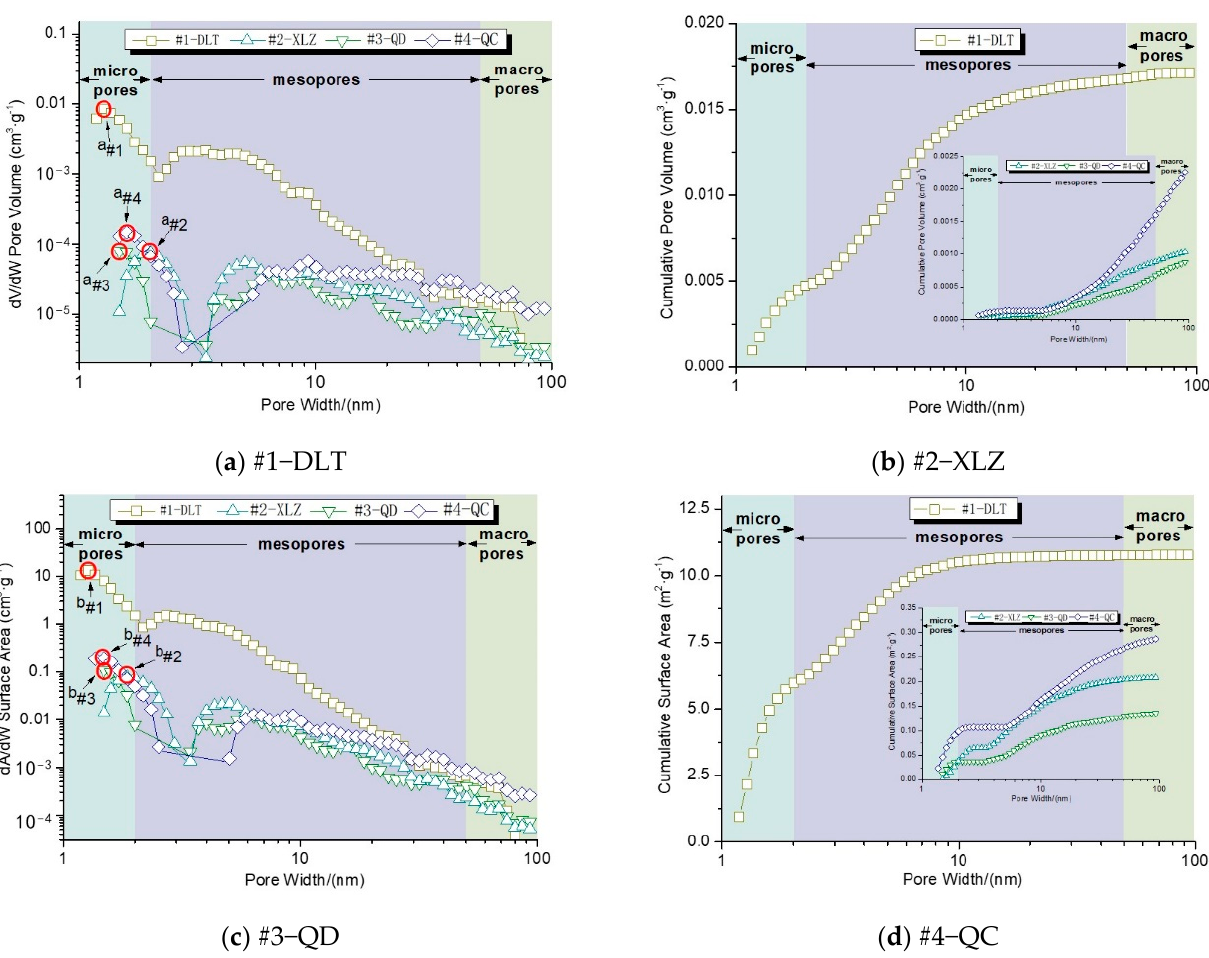
Figure 2. Adsorption and desorption curves of the four coal samples.